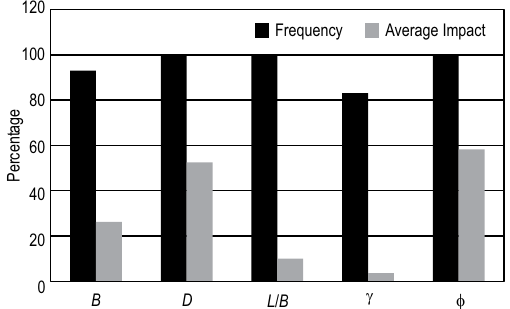
Fig. 9. Contributions of the predictor variables in the LGP analysis